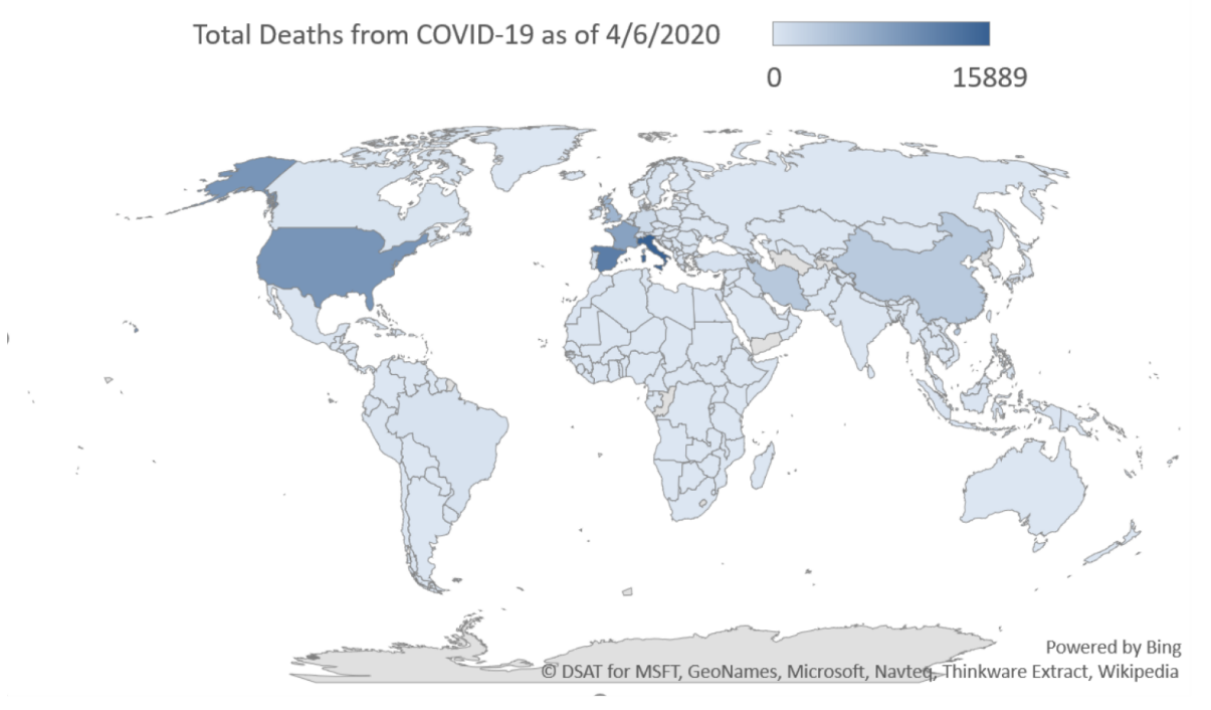
Figure 4. Geographic heat map of worldwide real-world deaths from COVID-19 as of April 6, 2020. COVID-19: coronavirus